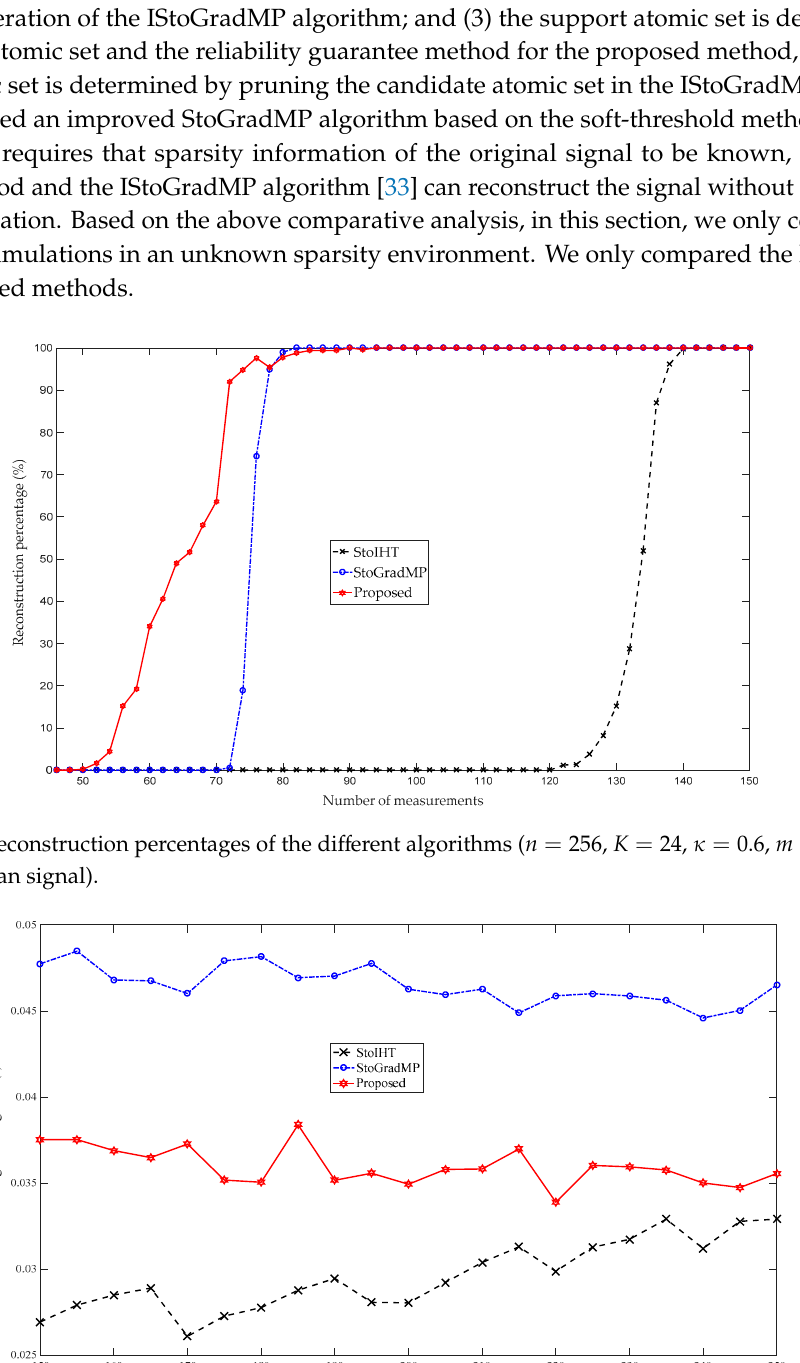
Figure 5. Reconstruction percentages of the StoGradMP and proposed algorithms (